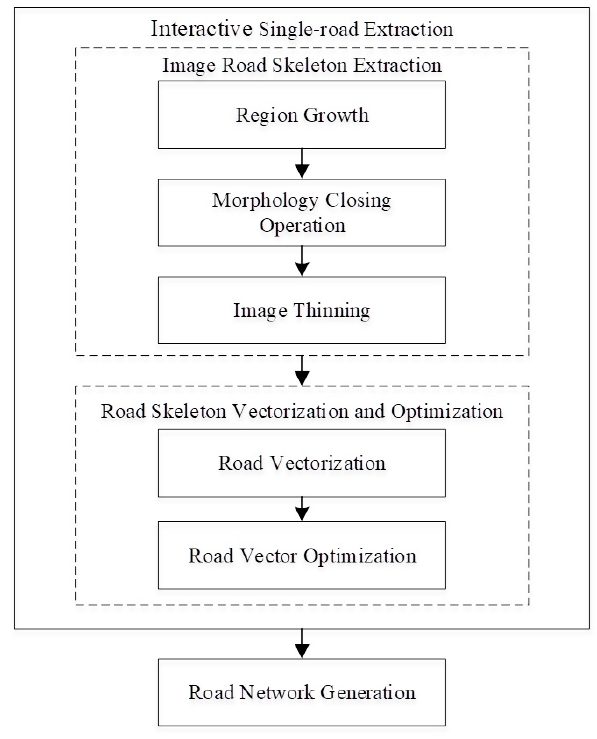
Figure 2. Road network extraction flow chart.